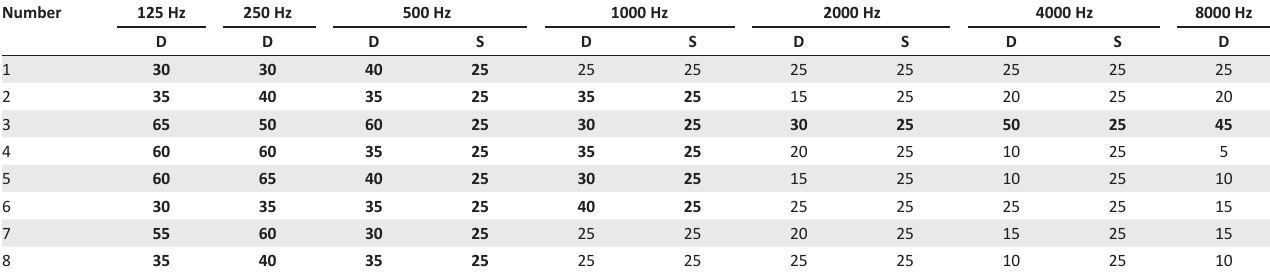
TABLE 2: Thresholds across frequency ranges for diagnostic (D) and screening (S) tests for eight false-negative screening